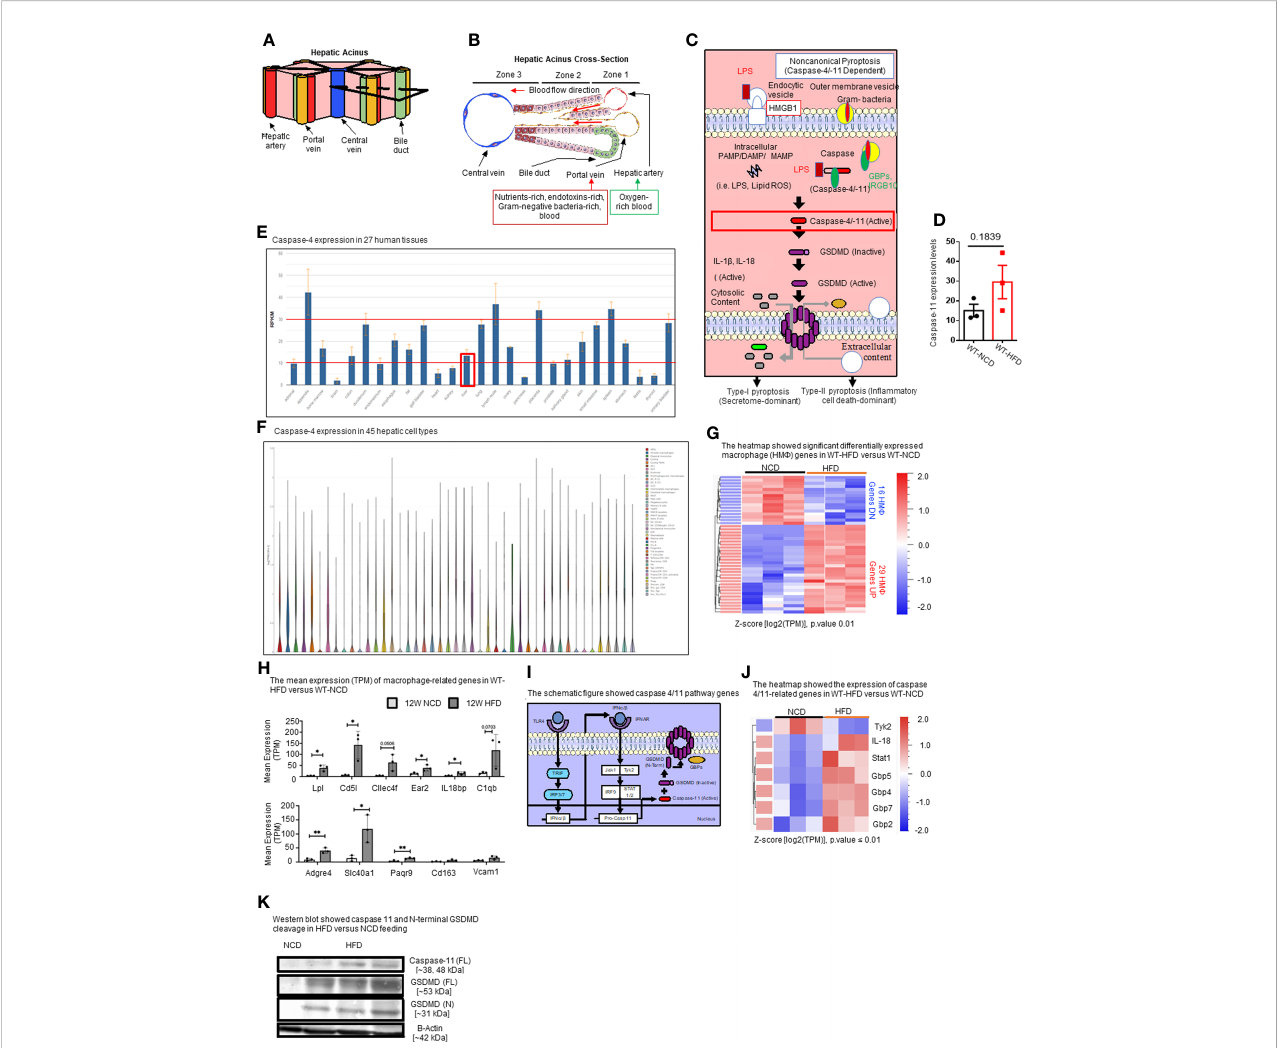
FIGURE 2 HFD upregulates the expressions of proin fl ammatory, NASH-related hepatic macrophage markers, GBPs, caspase-11, and increases N-terminal GSDMD cleavage. (A, B) The structure of hepatic acinus suggests that the liver is the fi rst organ exposed to endotoxins-rich and Gram bacteria-rich blood in the body. Liver parenchymal and nonparenchymal cells are organized into structures called “ acinus ” . Hepatic acini form hexagonal structures with a central vein and portal triad at the vertices. The hepatic acinus can be histologically divided into three zones. Zone 1 represents the portal triad which includes a hepatic artery, a portal vein, and a bile duct. Zone 2 represents the parenchymal area, structurally consisting primarily of hepatocytes with a central vasculature composed of liver sinusoidal endothelial cells (LSECs). Mature immune cells including B cells, T cells, innate-like lymphoid cells (ILCs), natural killer cells (NK cells), and tissue-resident macrophages (Kupffer cells) reside in hepatic acinus zone 1 and 2. Zone 3 represents the central vein, the innermost hepatocytes, and in fi ltrating immune cells. The portal vein contains nutrient-rich, endotoxins-rich, and gram bacteria-rich blood. (C) Noncanonical pyroptosis is caspase-4 (human), caspase-11 (mouse) dependent. Guanylate binding proteins (GBPs) promote the outer membrane vesicles from gram-bacteria to activate caspase-11. Intracellular sources of in fl ammation (including LPS and oxidized phospholipids) directly bind to caspase-4/-11. Caspase-4/-11 cleaves gasdermin-D to initiate noncanonical pyroptosis. (D) The expressions of caspase-11 in the liver were in an upregulation trend in high-fat diet-fed wild-type mice. The microarray data were achieved from the NIH-NCBI-Geo-Pro fi les database (GDS4811). (E) Caspase-4 expression in 27 human tissues. The expression of caspase-4 in the liver is at a medium level among all 27 human tissues. Caspase-4 RNA- Seq data were analyzed from the NIH-NCBI-Gene database (https://www.ncbi.nlm.nih.gov/gene/837). (F) Caspase-4 expression in 45 hepatic cell types. Caspase-4 is expressed in all 40 immune cell types, the single-cell RNA-Seq data were analyzed from the MIT Broad Institute Single Cell RNA-Seq (scRNA-Seq) Porter database (https://singlecell.broadinstitute.org/single_cell/study/SCP1845/cross-tissue-immune-cell-analysis-reveals-tissue-speci fi c- features-in-humans?genes=casp4&tab=distribution#study-visualize). Among 45 immune cell types identi fi ed in scRNA-Seq, 19 immune cell types are signi fi cantly enriched in the human liver including dendritic cell 1 (DC1), DC2, classical monocytes, non-classical monocytes, erythrophagocytic macrophages, mononuclear phagocytes (MNP)/B doublets, age-associated B cells (ABCs), plasma cells, Plasmablasts, MNP/B doublets, T/B doublets, mucosal-associated invariant T (MAIT), T_CD4/CD8, T effector memory (Tem)/effector memory re-expressing CD45RA (emra)_CD8, T resident memory cell/effector memory cell (Trm/em)_CD8, gamma-delta T cell (Tgd)_CRTAM+, Cycling T cell & natural killer cell (NK), NK_CD16+, and NK- CD56bright_CD16-. (G) 12-week HFD promotes expression of HM F activation mediators in the WT liver. 8-10 weeks old male WT mice were fed with HFD for 12 weeks. Heatmap of signi fi cant, differentially regulated macrophage (HM F ) genes. (H) Bulk RNA-seq expression (mean transcripts per kilobase million, TPM) of macrophage mediators. (I) Schematic representing caspase-4/11 pathway genes. (J) Bulk RNA-seq expression (mean TPM) of noncanonical pyroptosis-associated mediators. (K) Western blot analysis showed that HFD feeding increased caspase-11 and N-terminal GSDMD cleavage. Statistical Analysis: Bulk RNAseq analysis was performed using Qlucore Omics Explorer. Heatmap was generated using signi fi cantly differentially regulated genes (p.adj < 0.01). Differential gene expression presented as Z-score calculated from log2 transformed TPM. *P < 0.05, **p <